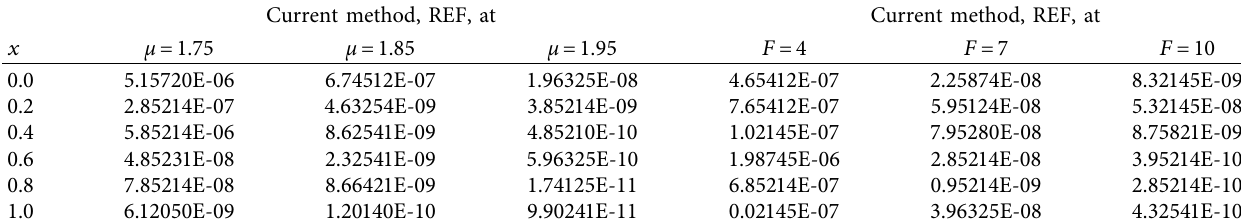
Table 1: A comparison of REF at T � 1 . 5 via different values of μ and F . f Current method, REF, at Current method, REF,